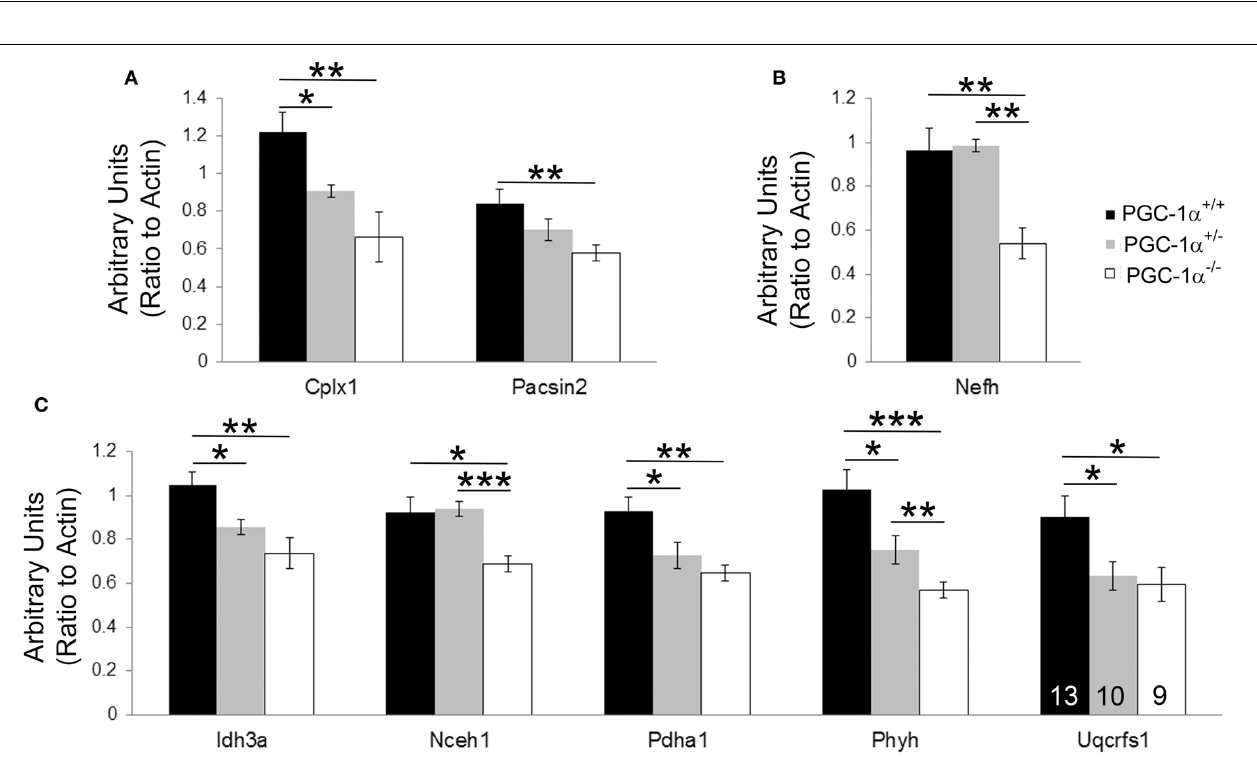
compared to their littermate controls. Representative digitized paw prints and associated step cycles are shown in (E) with RF, right front paw, RH, right hind paw, LF, left front paw, and LH, left hind paw. Two-tailed t -tests. ∗ p < 0 . 05 , ∗∗ p < 0 . 005 . n/group indicated on last bar histogram. Data are presented as mean ± SEM.